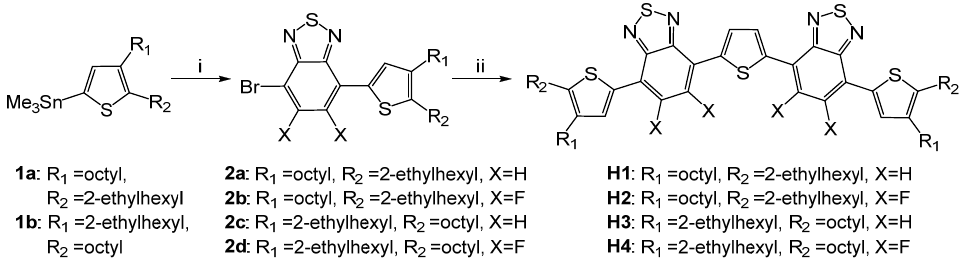
Figure 2. Synthesis of compounds H1 - 4 . Conditions: i—4,7-dibromobenzo[c]-1,2,5-thiadiazole or 5,6-difluoro- 4,7-dibromobenzo[c]-1,2,5-thiadiazole, Pd(PPh 3 ) 4 , toluene, reflux; ii—2,5-bis(tributylstannyl)thiophene, Pd(PPh 3 ) 4 , toluene,